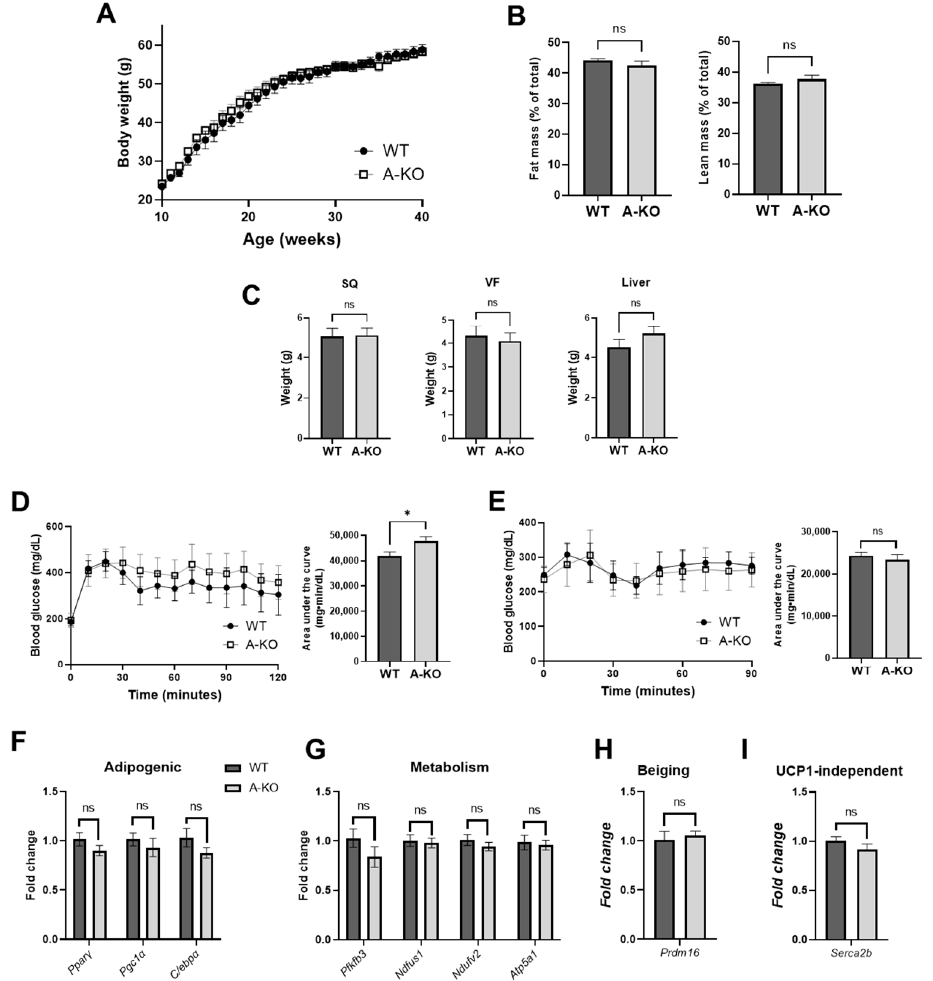
Figure 6. Adipocyte-specific HDAC9 gene deletion does not improve metabolic health in HFD-fed male mice. ( A ) Growth curves of HFD-fed male WT and A-KO mice ( n = 11–15). ( B ) Fat mass and lean mass measured by whole body composition nuclear magnetic resonance ( n = 10–12). ( C ) Tissue weight measurements of SQ, VF and liver at time of sacrifice ( n = 10–12). Glucose tolerance ( D ) and insulin tolerance test ( E ) quantified by area under the curve ( n = 4–5). mRNA expression of ( F ) adipogenic, ( G ) metabolic, ( H ) classic beiging and ( I ) UCP1-independent beiging genes in SQ from HFD-fed male mice ( n = 8). Data represent mean ± SEM. * p < 0.05, ns, not significant. SQ, subcutaneous adipose tissue; VF, visceral adipose tissue; PPAR ɣ , peroxisome proliferator-activated receptor gamma; Pgc1 ɑ , PPAR ɣ coactivator 1-alpha; C/ebp ɑ , CCAAT/enhancer-binding protein alpha; Pfkfb3, 6-phosphofructo-2-kinase/fructose-2,6-bisphosphatase 3; Ndfus1, NADH-ubiquinone oxi- subunit alpha; Prdm16, PR/SET domain 16; Serca2b; sarco/endoplasmic reticulum Ca 2+ ATPase 2b.